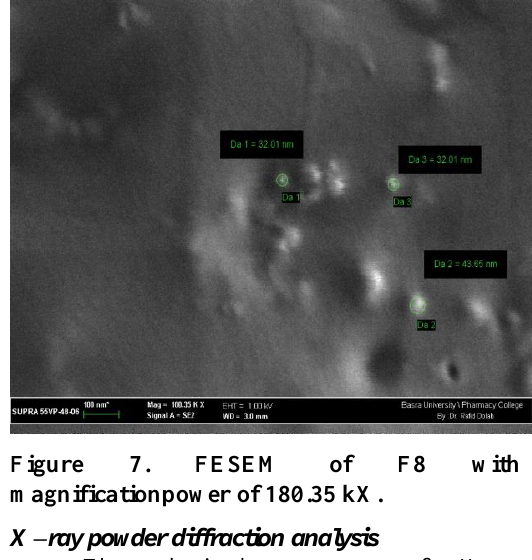
Figure 7. FESEM of F8 with magnificationpower of 180.35 kX.